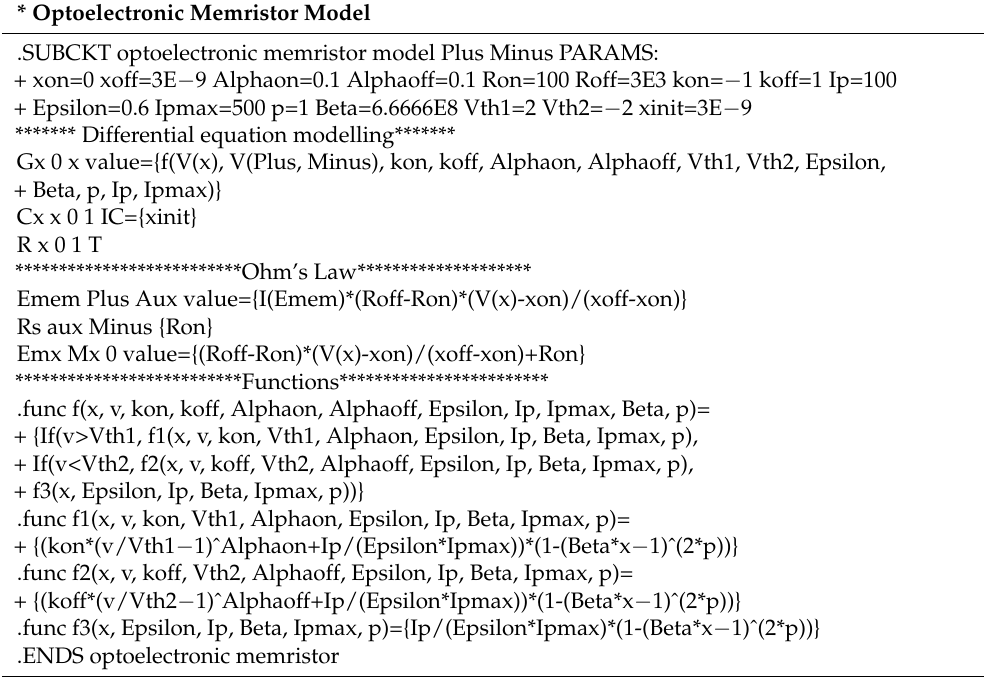
Table 2. PSPICE sub-circuit of optoelectronic memristor